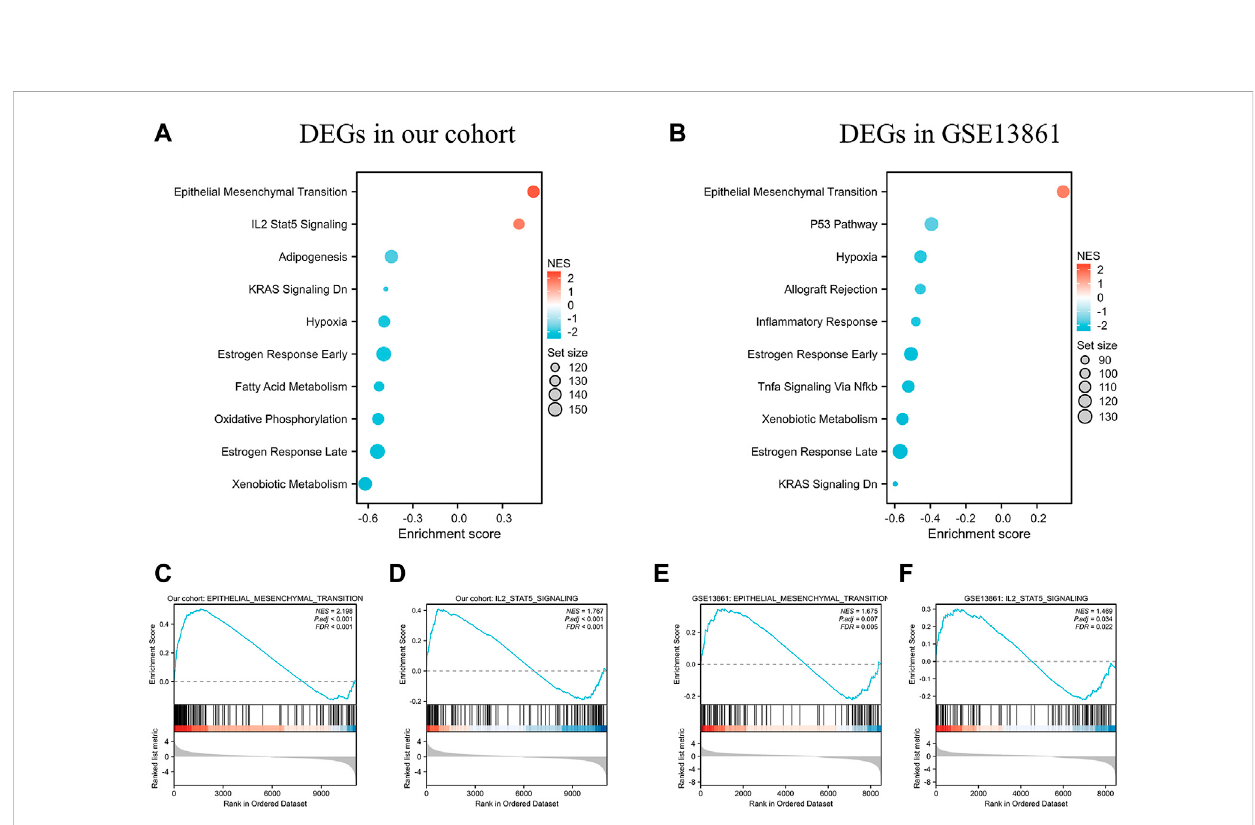
FIGURE 5 GSEAanalysisofDEGsinthedatasets. (A) Thetop10enrichedKEGGitemsfortheDEGsinourcohort,and (B) DEGsinGSE13861dataset.Taking p < 0.05 as the boundary value. Signi fi cant enrichment of the Epithelial Mesenchymal Transition (C) and IL-2 STAT5 Signaling (D) with DEGs in our cohort. Signi fi cant enrichment of the Epithelial Mesenchymal Transition (E) and IL-2 STAT5 Signaling (F) with DEGs in